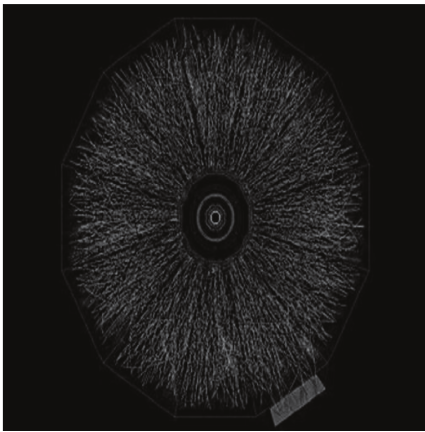
Figure 2: The original gray image of quark-gluon plasma.